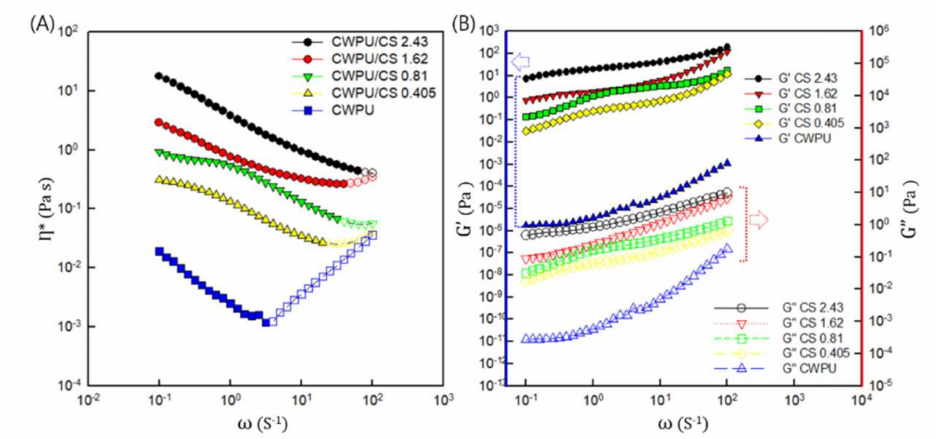
Figure 4. Dynamic oscillation behavior of CWPU and CWPU/CS nanocomposites according to CS contents: ( A ) dependence of the viscosity on the frequency and ( B ) dependence of G’ and G” on the